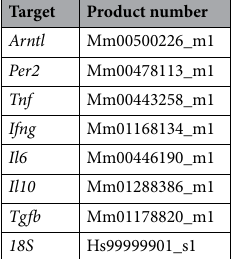
Table 1. List of primer sequences.